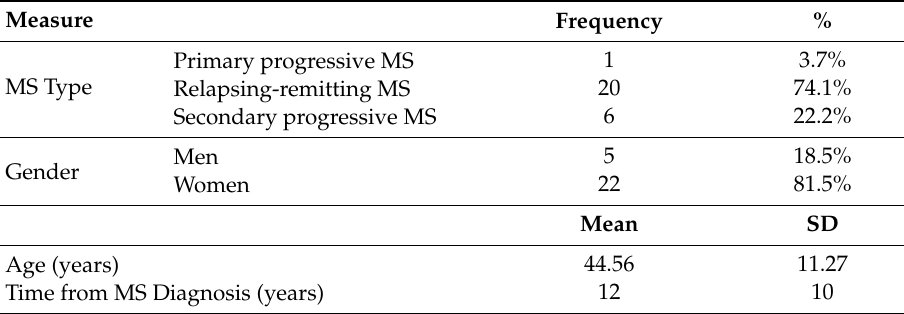
Table 1. Sociodemographic characteristics of the study